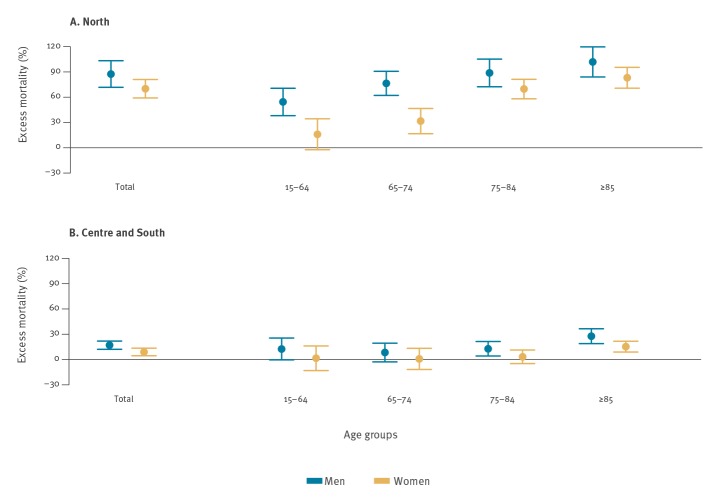
Excess mortality by sex and age groups (all ages, 15–64, 65–74, 75–84, ≥ 85 years) in northerna vs central and southernb cities, COVID-19 outbreak, Italy, starting datec–18 April 2020